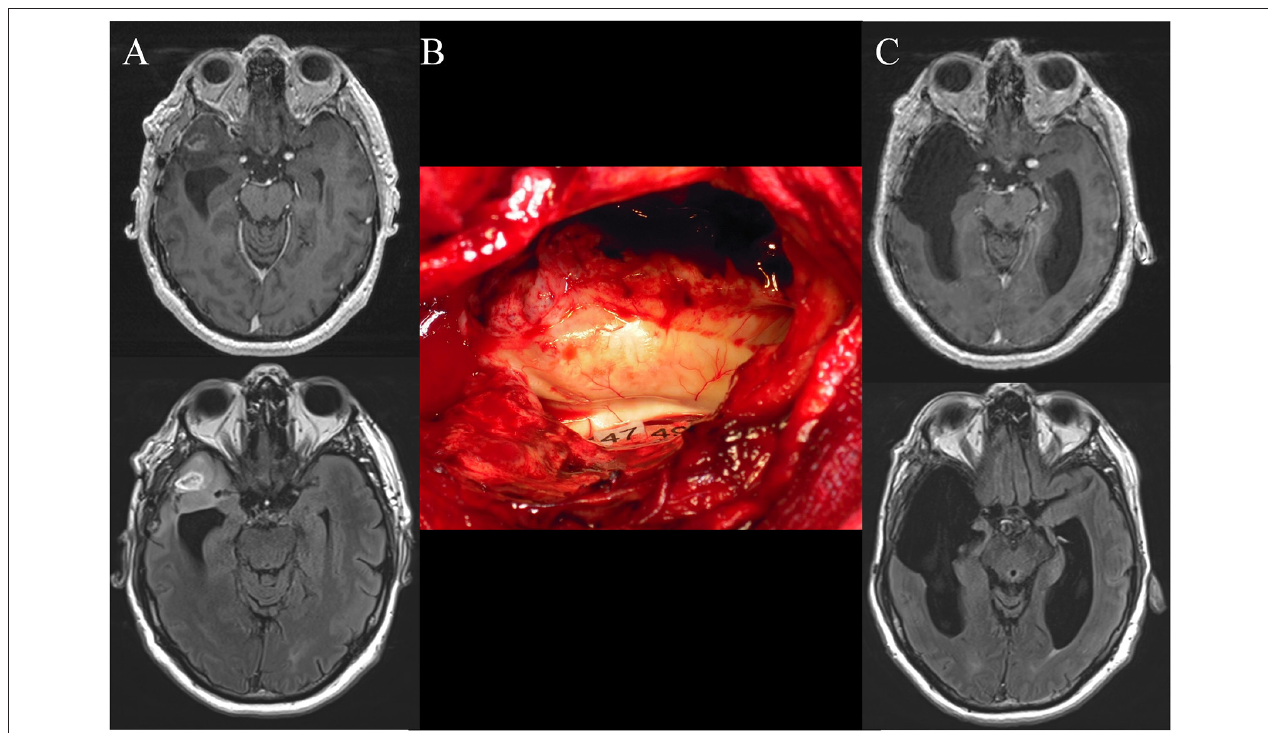
FIGURE 1 | (A) Preoperative axial enhanced T1-weighted MRI (upper) and FLAIR-weighted MRI (lower) achieved in a 50-year-old right-handed man who experienced seizures that allowed the discovery of a right anterior temporal high-grade glioma. The patient underwent a previous “minimal-invasive image-guided surgery” performed under general anesthesia in another hospital with a partial resection of the enhancement and the FLAIR hypersignal. An anaplastic astrocytoma was diagnosed. At that time, the patient was referred to our department and a reoperation was proposed with awake mapping in order to achieve a supratotal resection according to functional boundaries. The neurological examination was normal. Nonetheless, the preoperative neuropsychological evaluation revealed a slight deficit of higher-cognitive functions, that is, theory of mind and semantic processing. (B) Intraoperative view after resection, achieved up to eloquent structures, especially at the subcortical level. Indeed, direct electrostimulation of white matter tracts enabled the identification of the subcortical neural networks involved in theory of mind (mentalizing) (tag 47) and non-verbal semantics (tag 49) - which have been mapped according to the results of the presurgical neurocognitive assessment. (C) Postoperative axial enhanced T1-weighted MRI (upper) and FLAIR-weighted MRI (lower) (performed 3 months after resection) demonstrating a supracomplete resection of both the enhancement and the FLAIR hypersignal. The patient recovered, with an improvement of the neuropsychological examination thanks to a post-surgical cognitive rehabilitation. A diffuse WHO grade III astrocytoma (IDH1 mutated, non-codeleted) was diagnosed, and postoperative chemotherapy was administrated, with no radiotherapy. The imaging is stable with 4 years of follow-up, and the patient continues to enjoy a normal life, with no